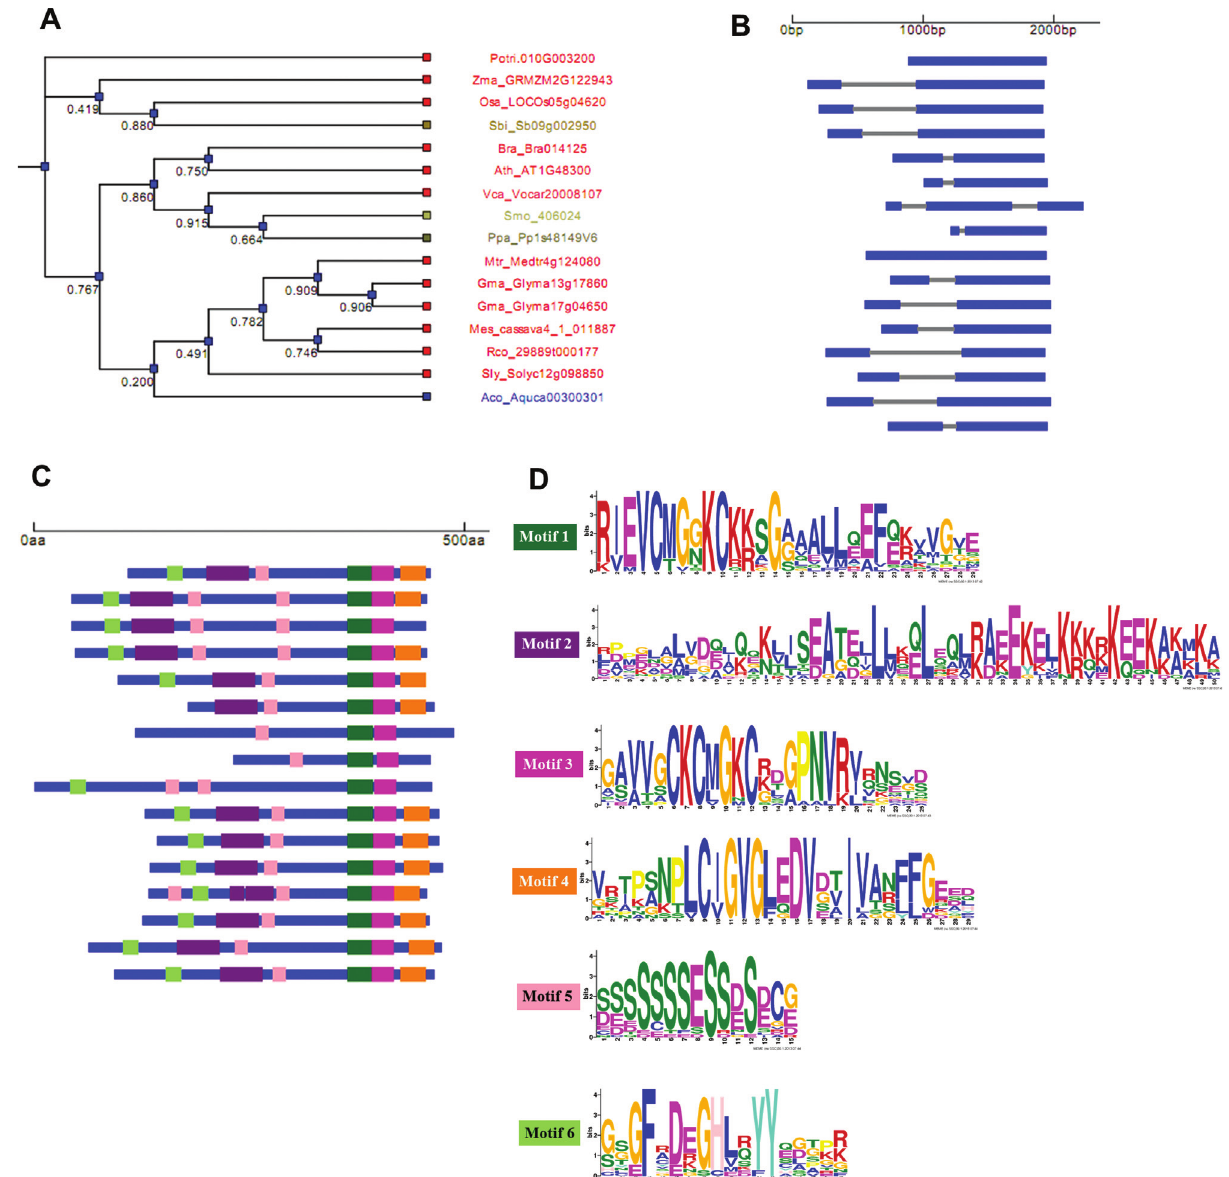
Figure 2 - DGAT3 gene structure and organization in plant genomes. Dendrogram of sequences clustered according to the presence and similarity of identified protein motifs (A). Diagram displaying information of the gene structure for each sequence (B). Conserved motifs identified on protein se- quences (C) and sequence logo of the conserved motif (D). Exon sequences are represented as blue boxes and the gray bars represent introns. The species included in this analysis are listed in the Table 1. The bootstrap values are given below the branches of the